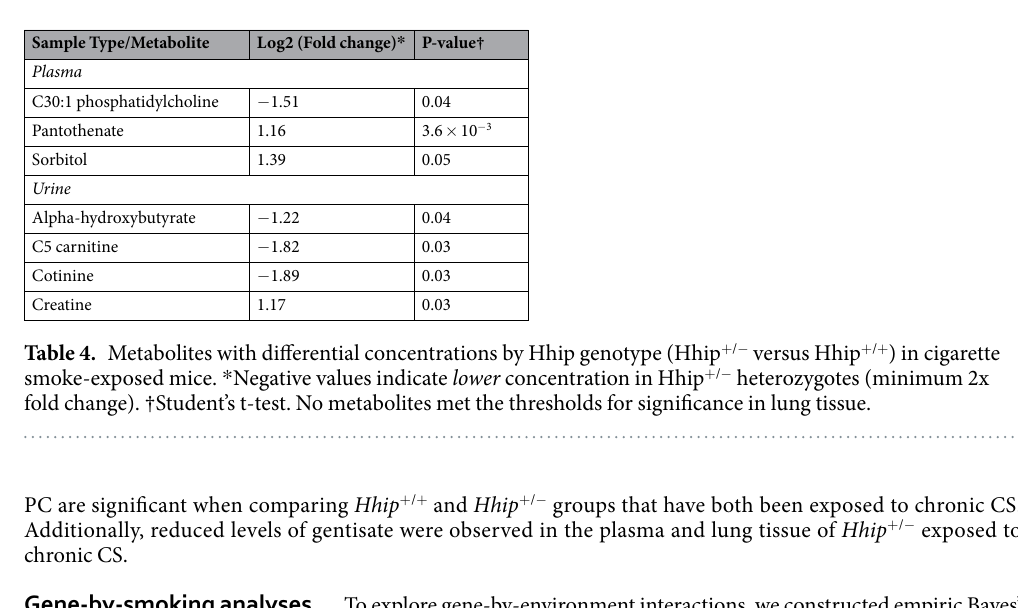
Figure 1. Urinary and plasma cotinine levels by genotype. Urinary cotinine (normalized for creatinine concentration) relative to plasma cotinine in Hhip + / − heterozygotes (left panel) and Hhip + / + wild type mice (right panel) subjected to chronic cigarette smoke. In Hhip + / + wild type mice, a strong inverse correlation between urine and plasma cotinine levels exist (Pearson rho = − 0.89, p-value = 0.04) whereas in Hhip + / − heterozygotes, no correlation was found (Pearson rho = 0.12, p-value = 0.88). The best fit line is plotted in blue while the 95% confidence interval is plotted in dark gray.